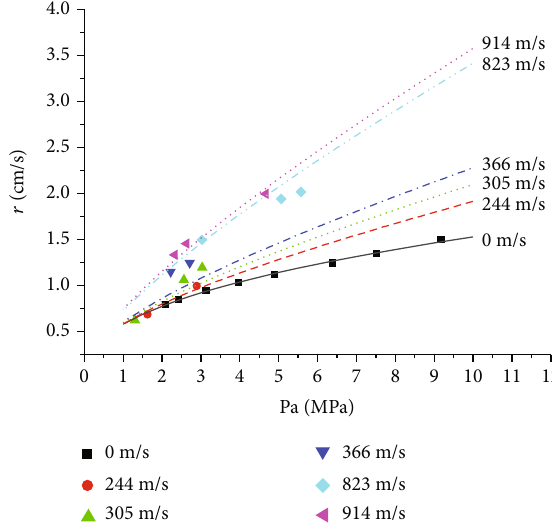
Figure 2: Propellant 5051.